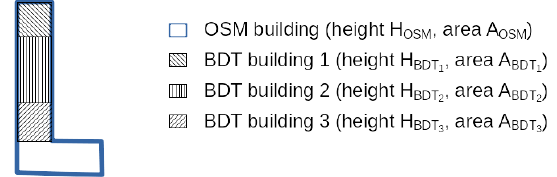
Figure 4. Example of the overlap between OSM and BDT build-